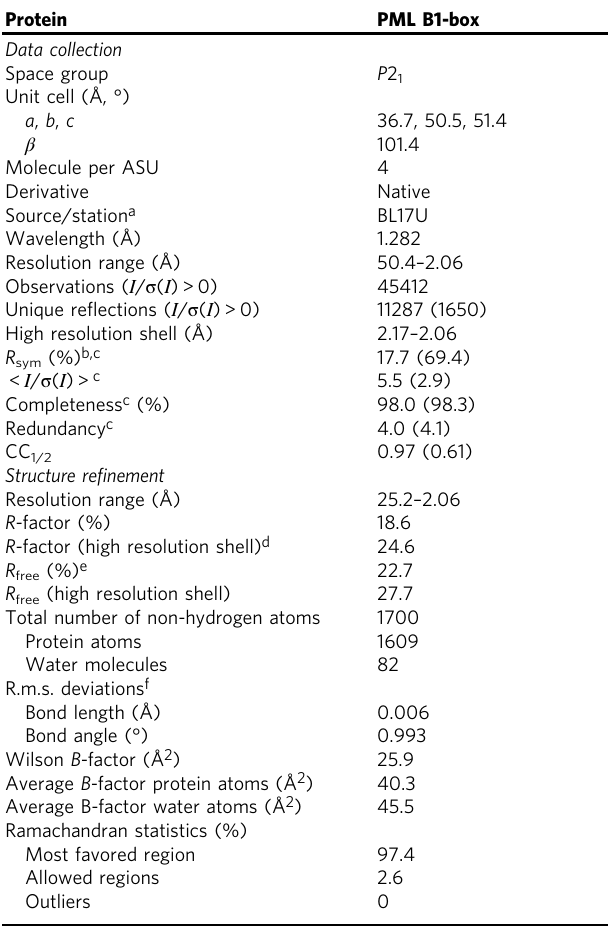
Table 1 Data collection and structure re fi nement statistics